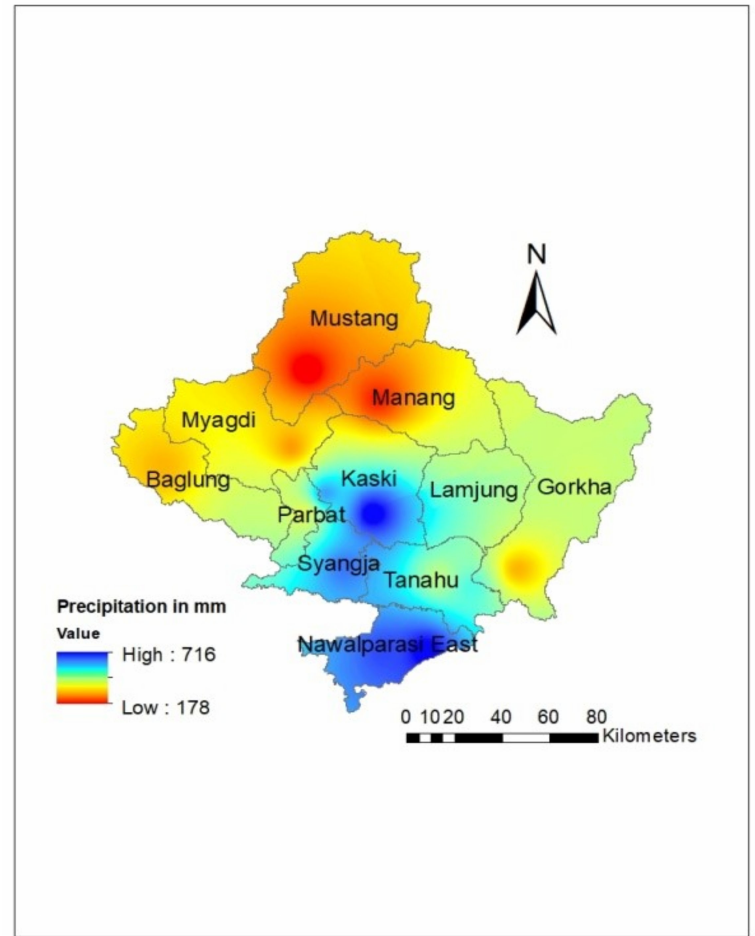
Figure 8. The 100-year return period’s precipitation from the MRI-ESM2-0 model for the near future. Extreme precipitation for 5-, 10-, 20-, 50-, and 100-year return periods was